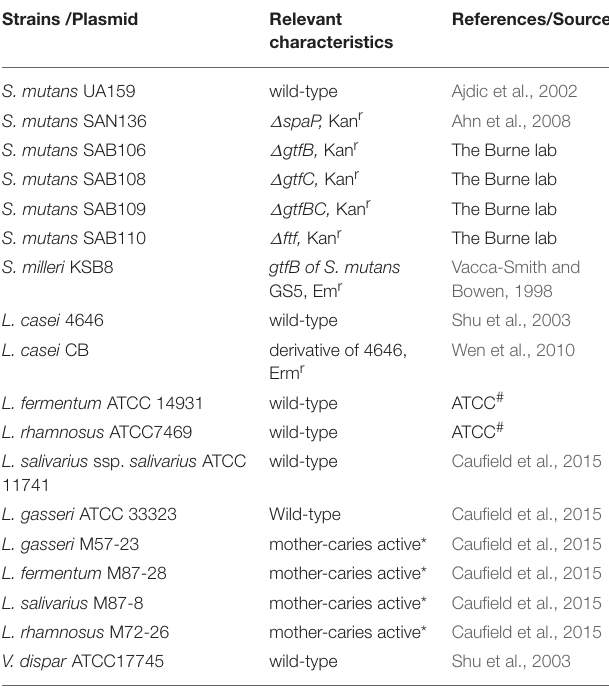
TABLE 1 | Bacterial strains used in this study. Strains